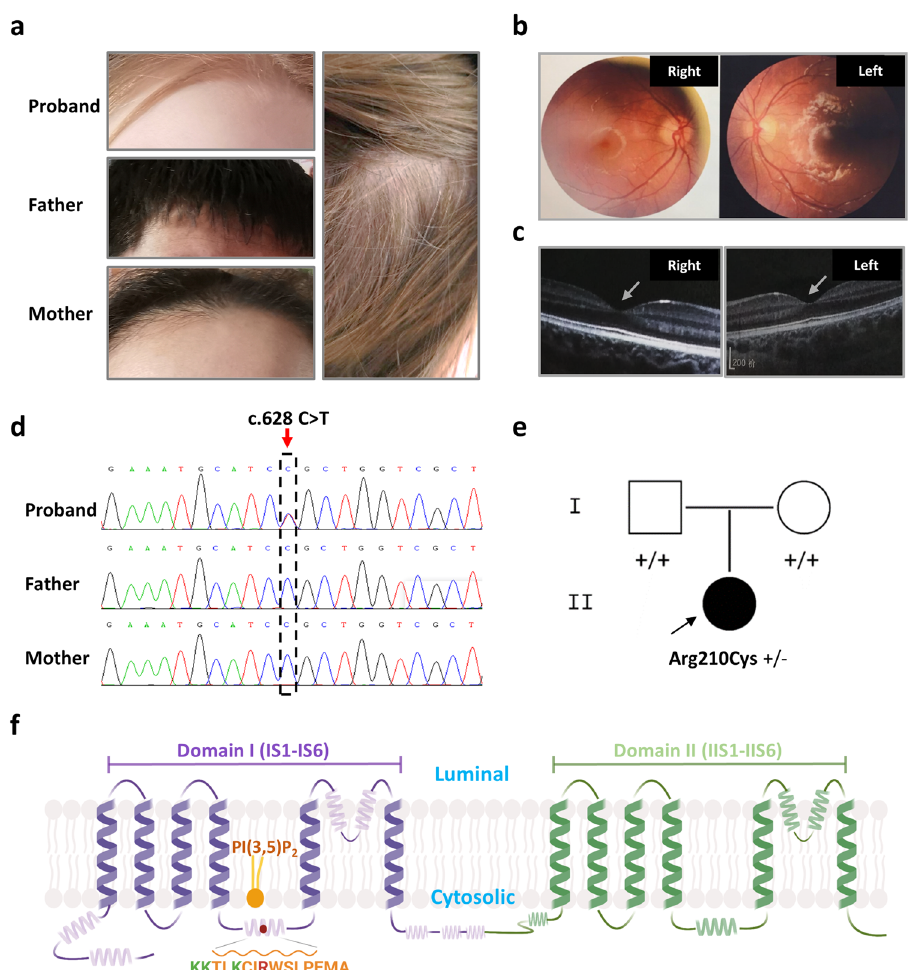
Fig. 1 | Clinical manifestations and a point mutation of TPCN2 gene in the proband. a The proband with hypopigmented skin and hair is shown. Her hair exhibitedmixtureofwhite,blond,andbrowncolors(rightpanel).Herparentswere with normal pigmentation. b Normal pigmented retinas and well-developed maculae of the proband. c Optical coherence tomography (OCT) examination of the proband presented normalfoveae as the arrows show. d Histograms of Sanger sequencingdatafromtheprobandandherparentsrevealedac.628C>T(p.R210C) mutation (in dashed box) in the TPCN2 gene of the proband (red arrow). Source data of Sanger sequencing are provided as a Source Data fi le. e A pedigree chart showing the de novo p.R210C mutation of the proband indicated by the arrow. f Schematic model of TPC2 secondary structure anchored on a lipid bilayer. TPC2